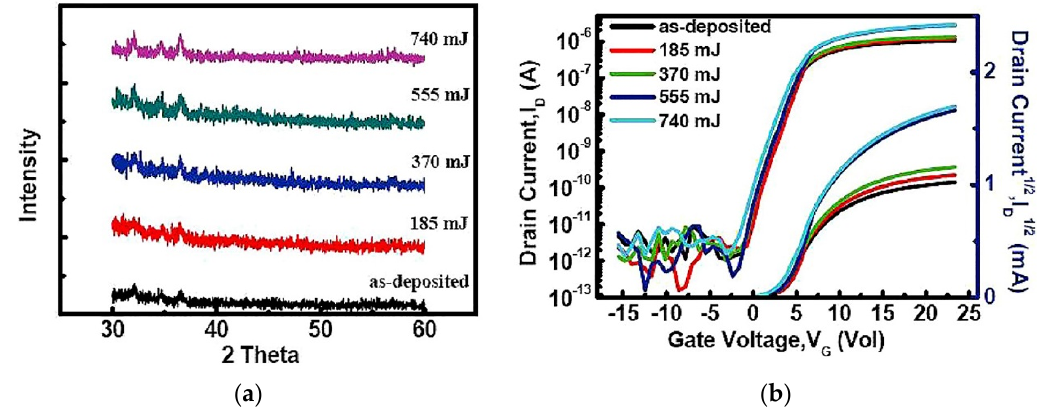
Figure 8. Crystallization degree of ZnO thin films and transmission characteristics of ZnO-TFT devices under different laser energy densities: ( a ) degree of crystallization; ( b ) transmission characteristics [58].